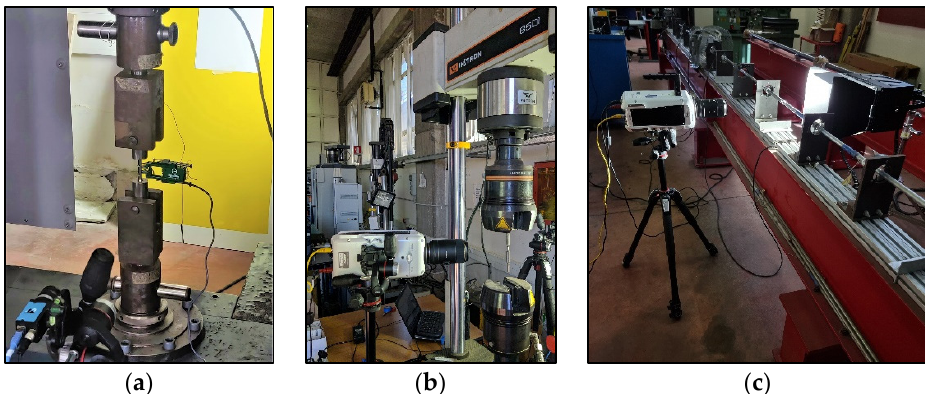
Figure 2. Motor-driven machine and clip gauge used for the static tests ( a ), hydraulic machine used for the dynamic tests at intermediate strain rates ( b ) and SHTB used for the dynamic tests at high strain rates ( c ).